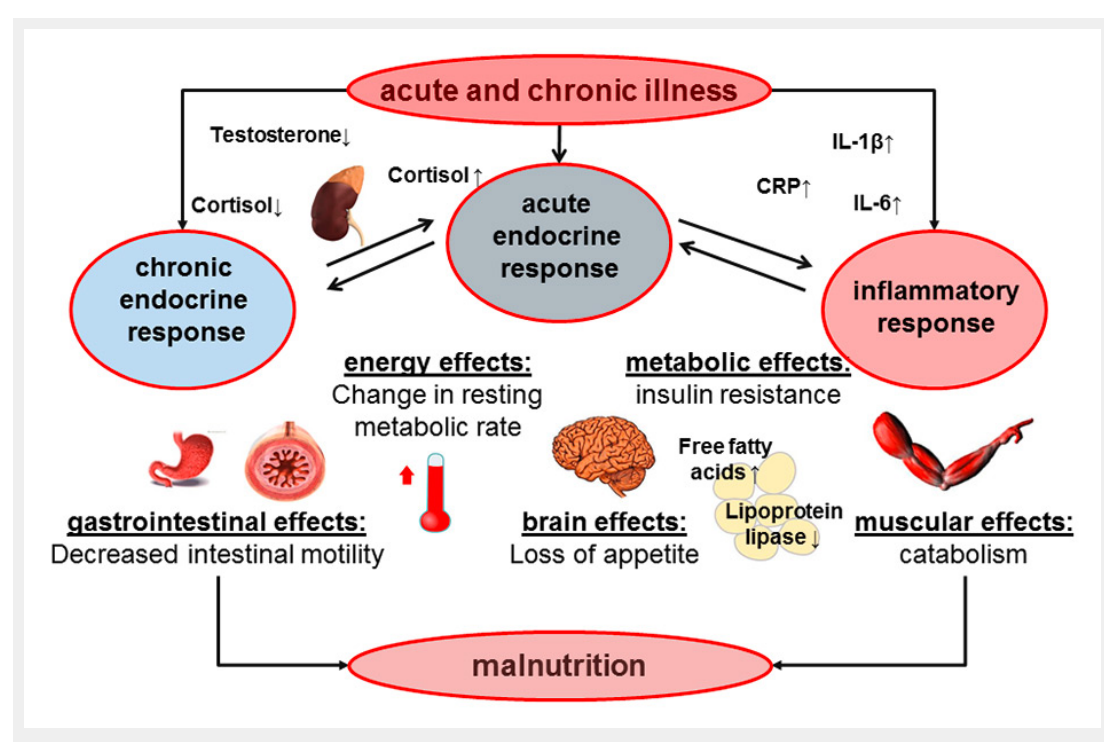
Figure 1 Summary of physiopathological mechanisms occurring during acute and chronic illnesses including endocrine and inflammatory pathways leading to malnutrition. CRP = C-reactive protein; IL =